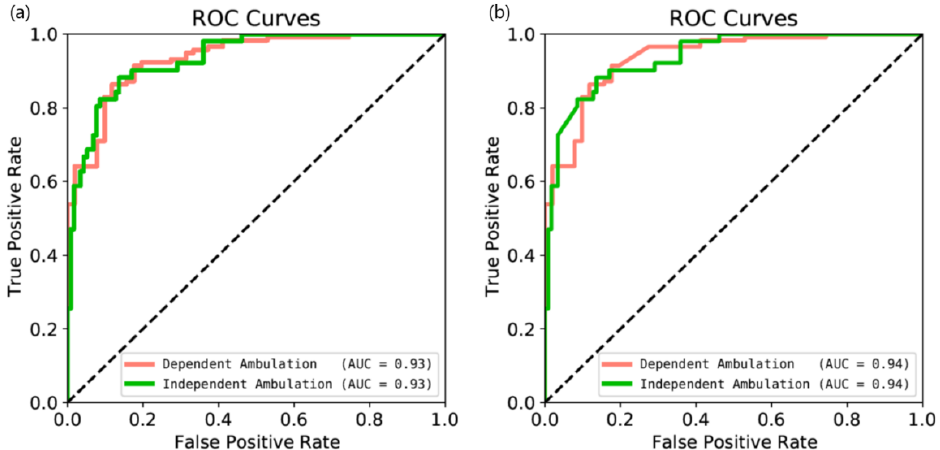
Table 3. The detection scores (accuracy, recall, precision, and F-1 Score) of dependence in ambula- tion using a trained 3D-CNN model combined with measurement swing time asymmetry.